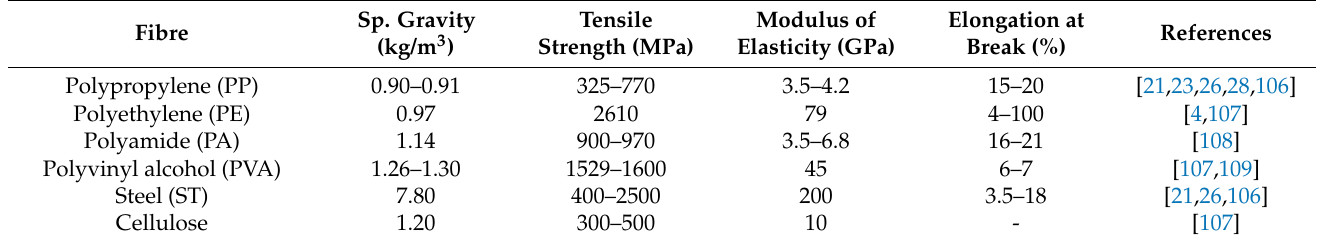
Table 4. Basic characteristics of